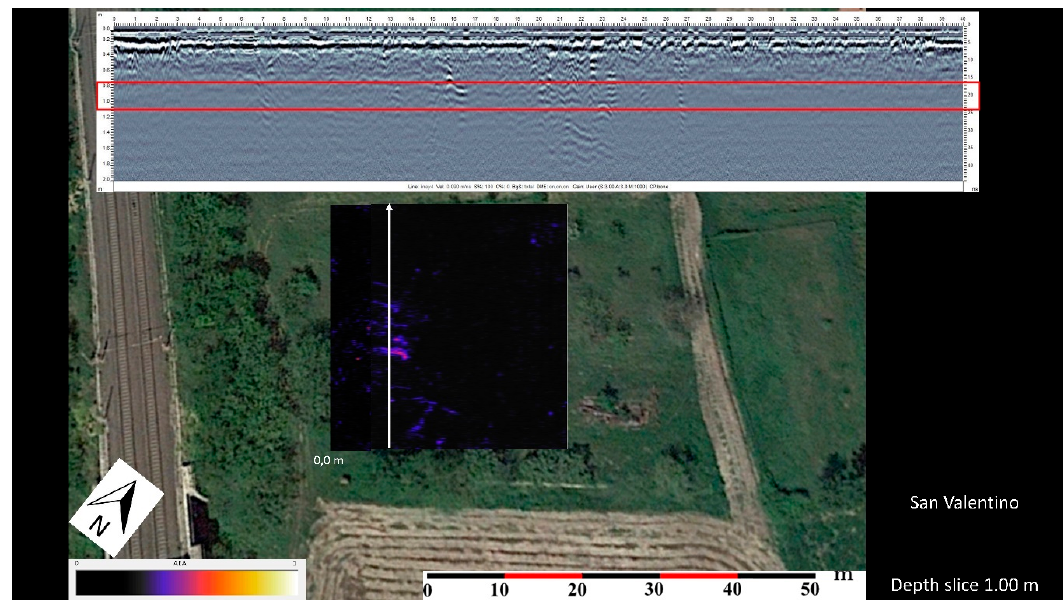
Figure 7. The GPR map at 1 m depth, in which several perpendicular and linear anomalies, probably due to manmade walls, are visible. Note that there are parch marks on the surface that correspond to these anomalies. Above is the radargram collected along the white arrow, with a red rectangle indicating the relative depth of the map.